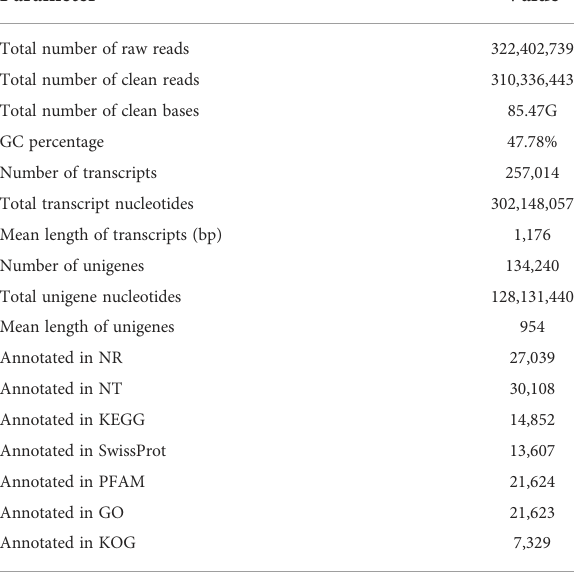
TABLE 2 An overview of the Illumina sequencing of the M. separata transcriptome.